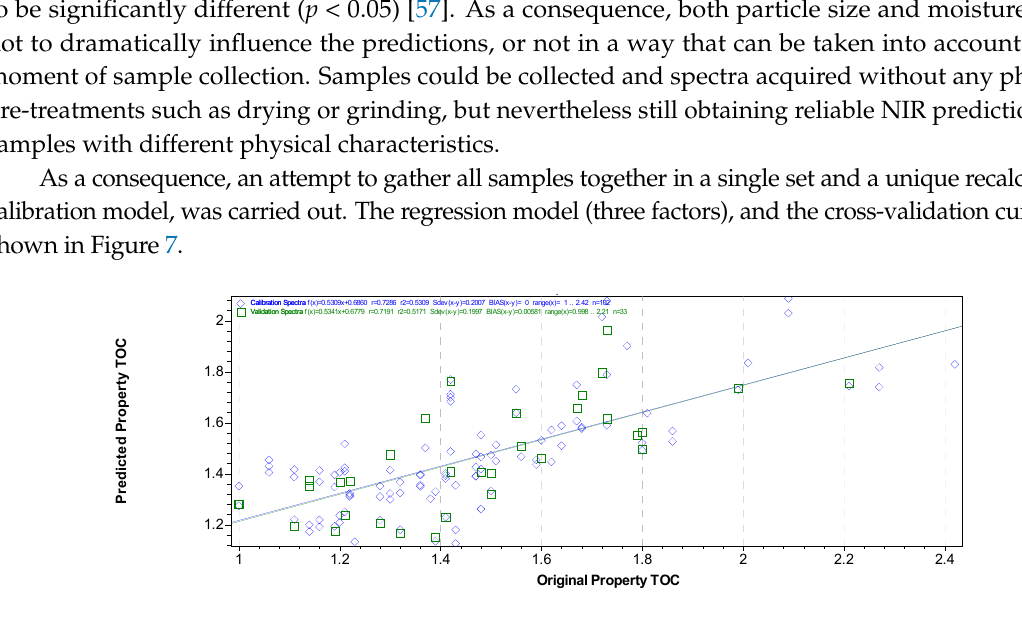
Figure 7. Calibration curve for parameter TOC in soils of original vs. predicted values grouping together all three data sets.